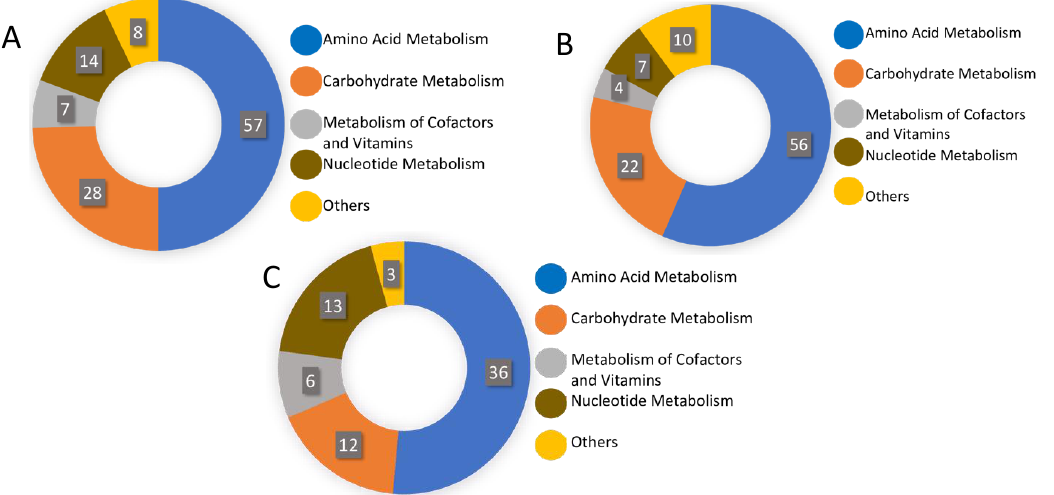
Figure 2. Distribution of total putative metabolites by different metabolite classes ( A ) in the somatic extract of infective third-stage larvae (L3) of N. brasiliensis (NB_SE); ( B ) in the excretory/secretory products of N. brasiliensis L3 (NB_ESP); and ( C ) in the somatic extract of T. muris embryonated eggs